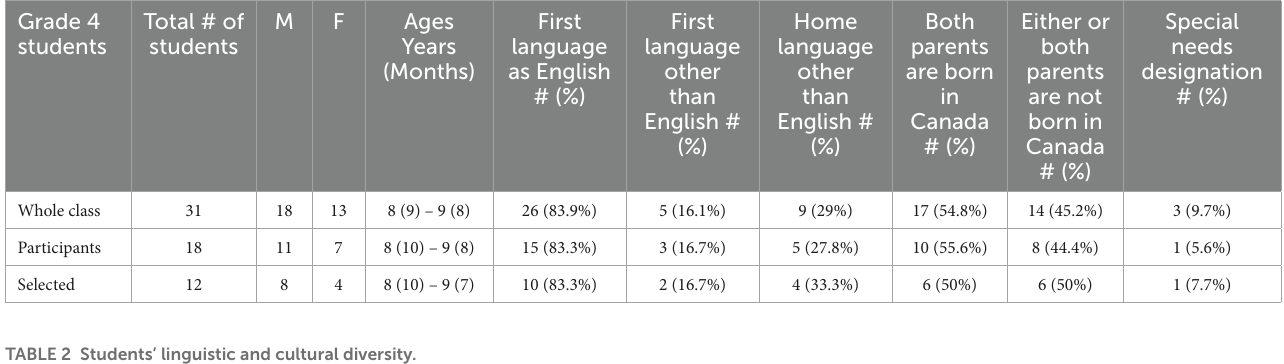
TABLE 1 Student demographics.